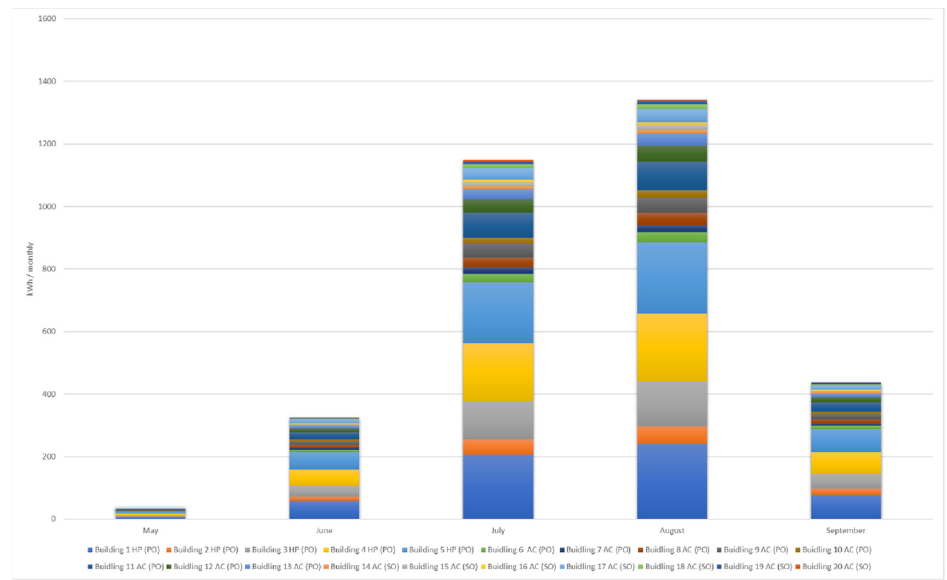
Figure 7. Baseline energy consumption for cooling.